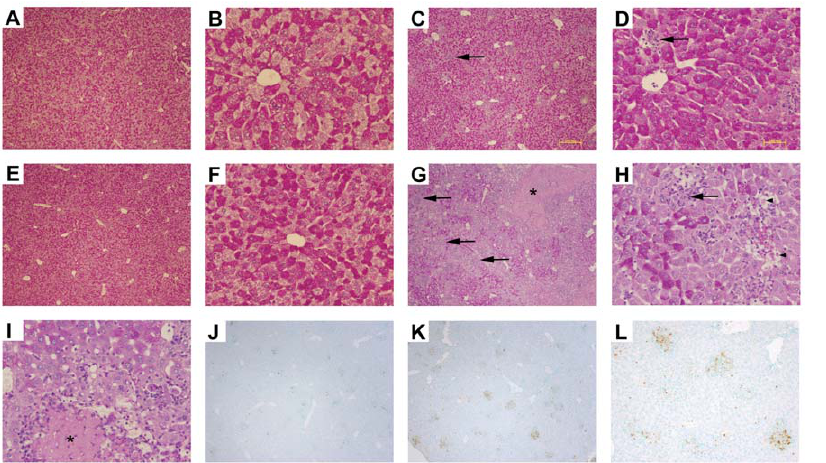
Figure 7. Liver pathology during acute MCMV infection in the absence of IL-10. Livers from (A, B, C, D) C57BL/6J (WT) and (E, F, G, H) IL- 10 2 / 2 mice that were (A, B, E, F) uninfected or (C, D, G, H, I, J, K, L) infected with MCMV for 5 days were harvested, paraffin embedded, and sectioned for PAS staining. Inflammatory foci (arrows, C, D, G & H), necrosis (asterisks, G and I), councilman bodies (black arrowheads, H), are marked. TUNEL positive cell clusters are shown in (J) Day 5 WT and (K and L) IL-10 2 / 2 livers. A, C, E, G, J & K were visualized at 6 4 magnification. B, D, F, H, & I at 6 20